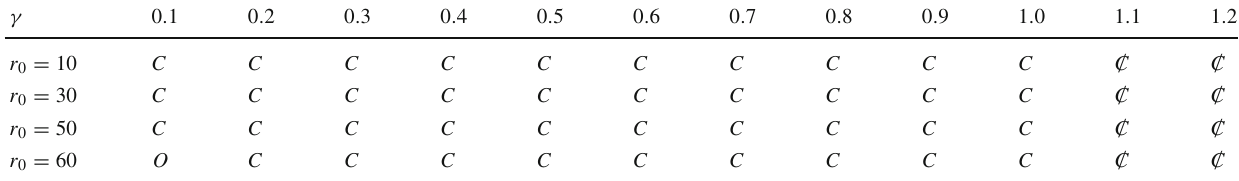
given by observing the behaviors of the maximum Lyapunov exponent log 10 | λ | as the function of log 10